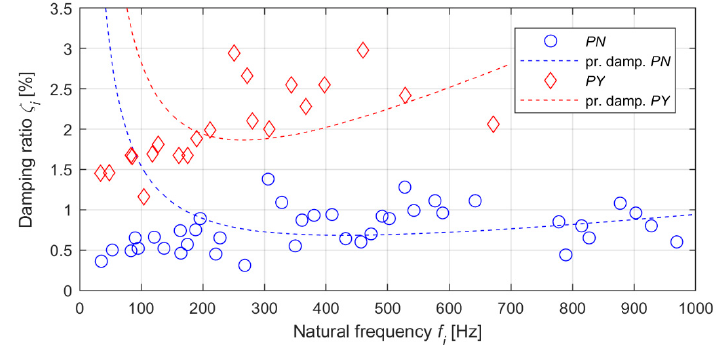
Figure 6. Modal parameters with proportional damping interpolating curves.